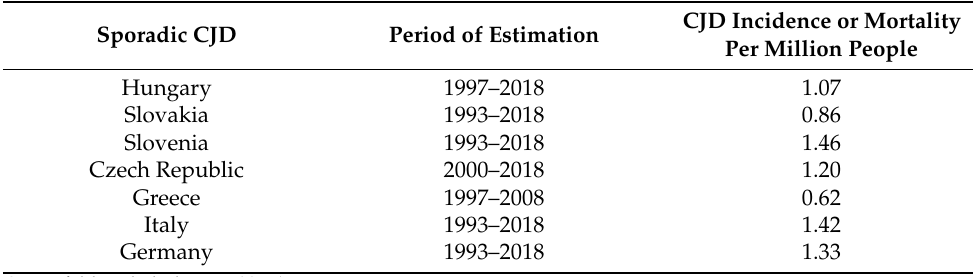
CJD Incidence or